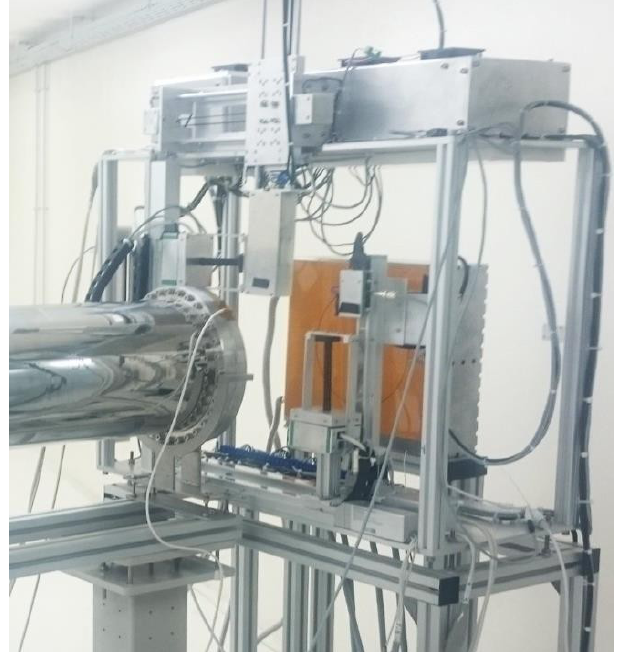
Fig. 16. Test table of METU-DBL pretest. The detectors and DUTs are attached in the cross- shaped holders and are moved by the servo motors in the new design of METU-DBL test mechanism. The speed, acceleration and position control devices of the servo motors can be set independently of the PLC or can be controlled manually using a software.